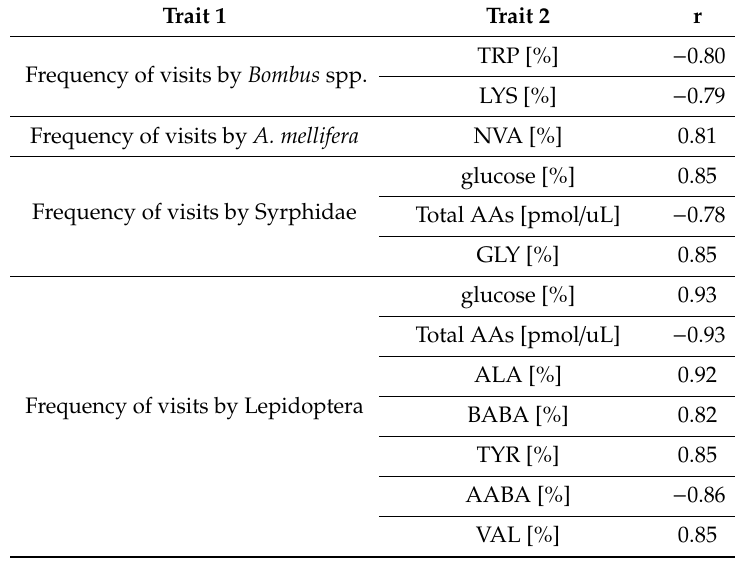
Table 4. Correlations between nectar traits and habitat parameters with variables that were not included in the LMM models. TRP (tryptophan), LYS (lysine), NVA (norvaline), GLY (glycine), ALA (alanine), BABA ( β -alanine), TYR (tyrosine), AABA ( α -aminobutyric acid), VAL (valine). Table contains only significant results ( p < 0.05). Trait 1 Trait 2 r TRP [%] − 0.80 Frequency of visits by Bombus spp. LYS [%] − 0.79 Frequency of visits by A. mellifera NVA [%] 0.81 glucose [%] 0.85 Frequency of visits by Syrphidae Total AAs [pmol / uL] − 0.78 GLY [%] 0.85 glucose [%] 0.93 Total AAs [pmol / uL] − 0.93 ALA [%] 0.92 Frequency of visits by Lepidoptera BABA [%] 0.82 TYR [%] 0.85 AABA [%] − 0.86 VAL [%]